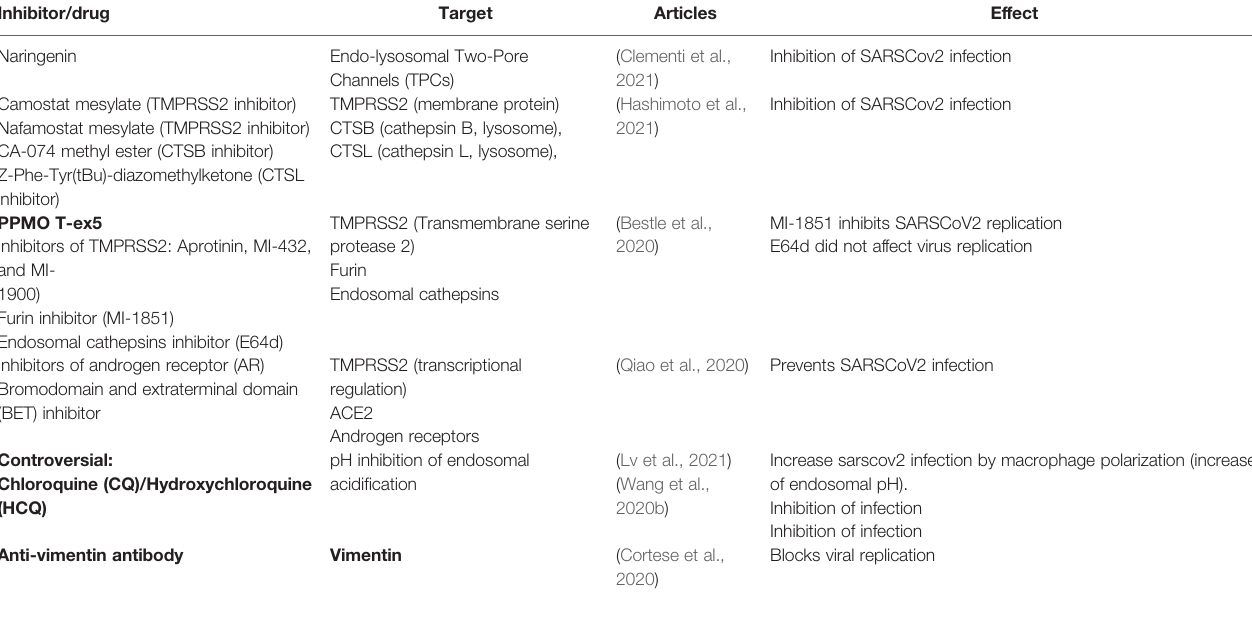
TABLE 2 | New therapeutic targets against SARSCoV2 showing manuscripts that used microscopy experiments for testing drugs for SARS-CoV-2 inhibition.